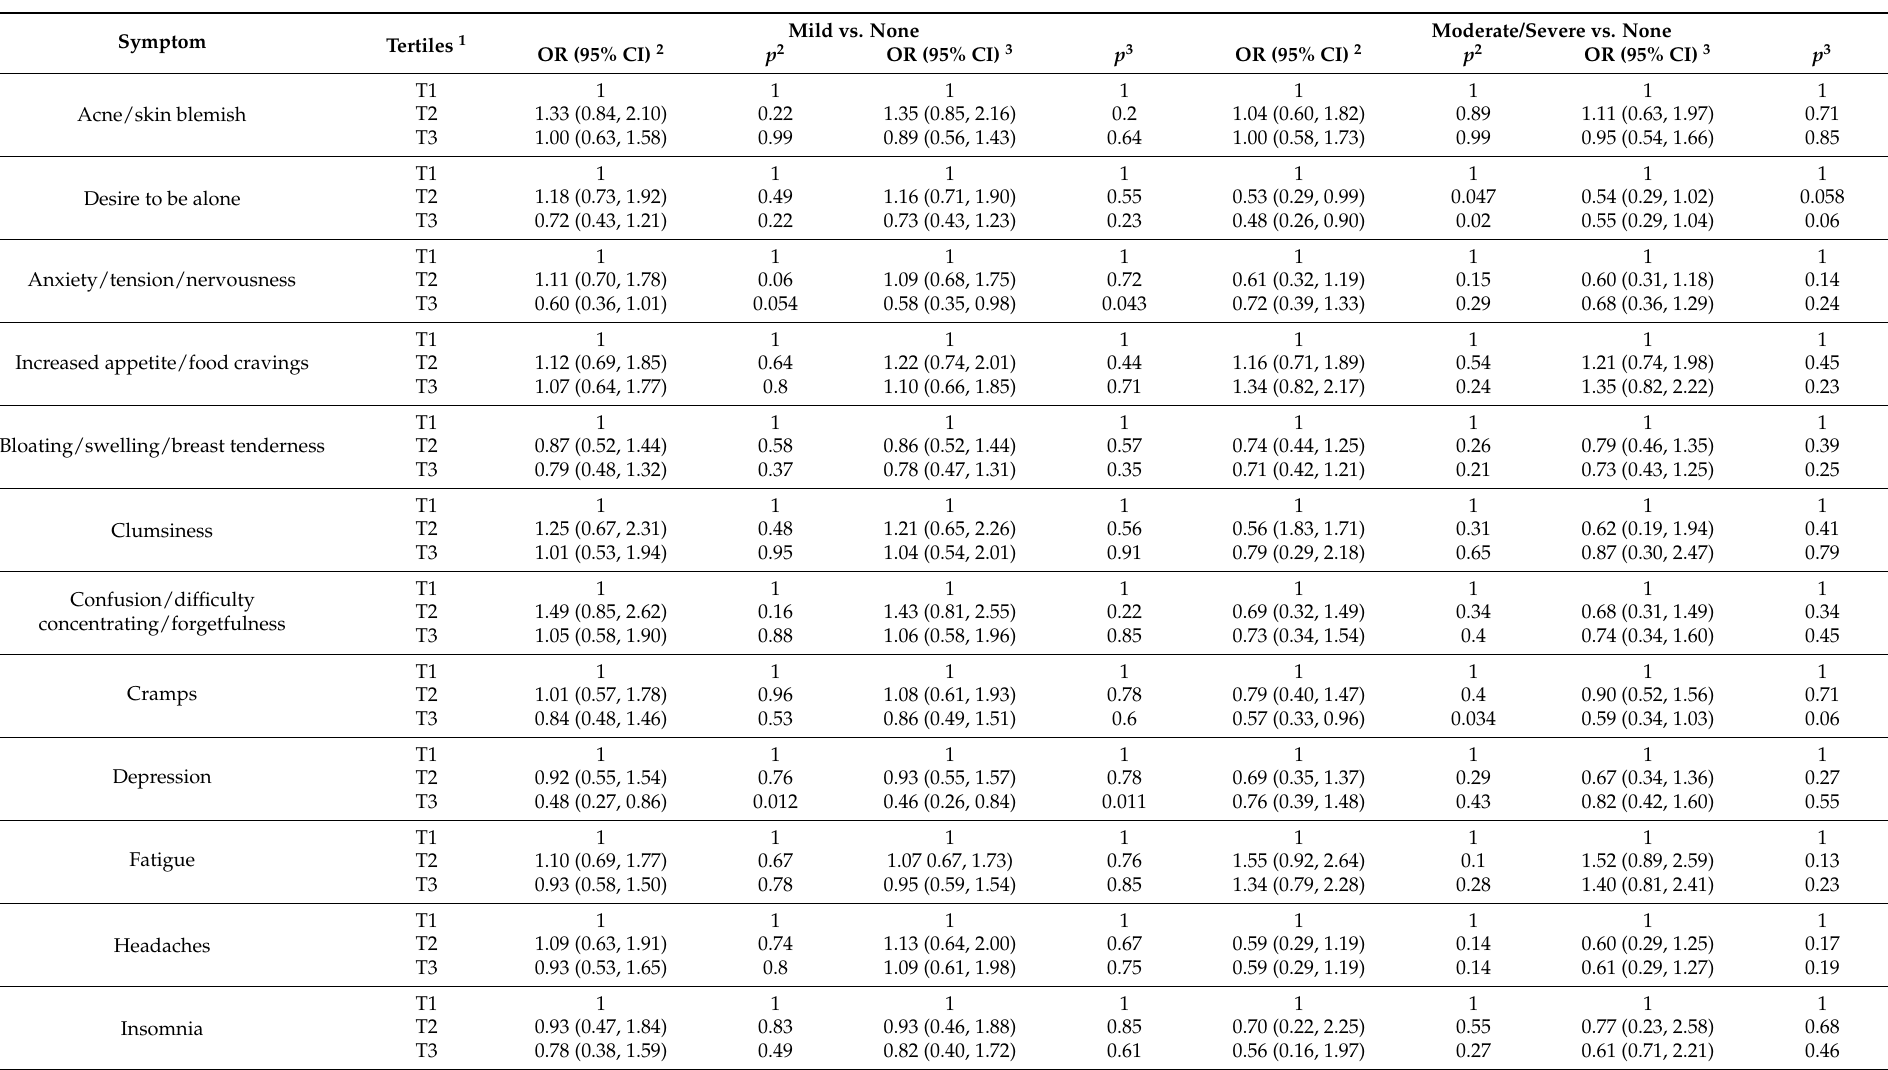
Table 4. Unadjusted and adjusted Odds Ratios and 95% CIs for the association between tertiles of plasma alpha-carotene and premenstrual symptoms.